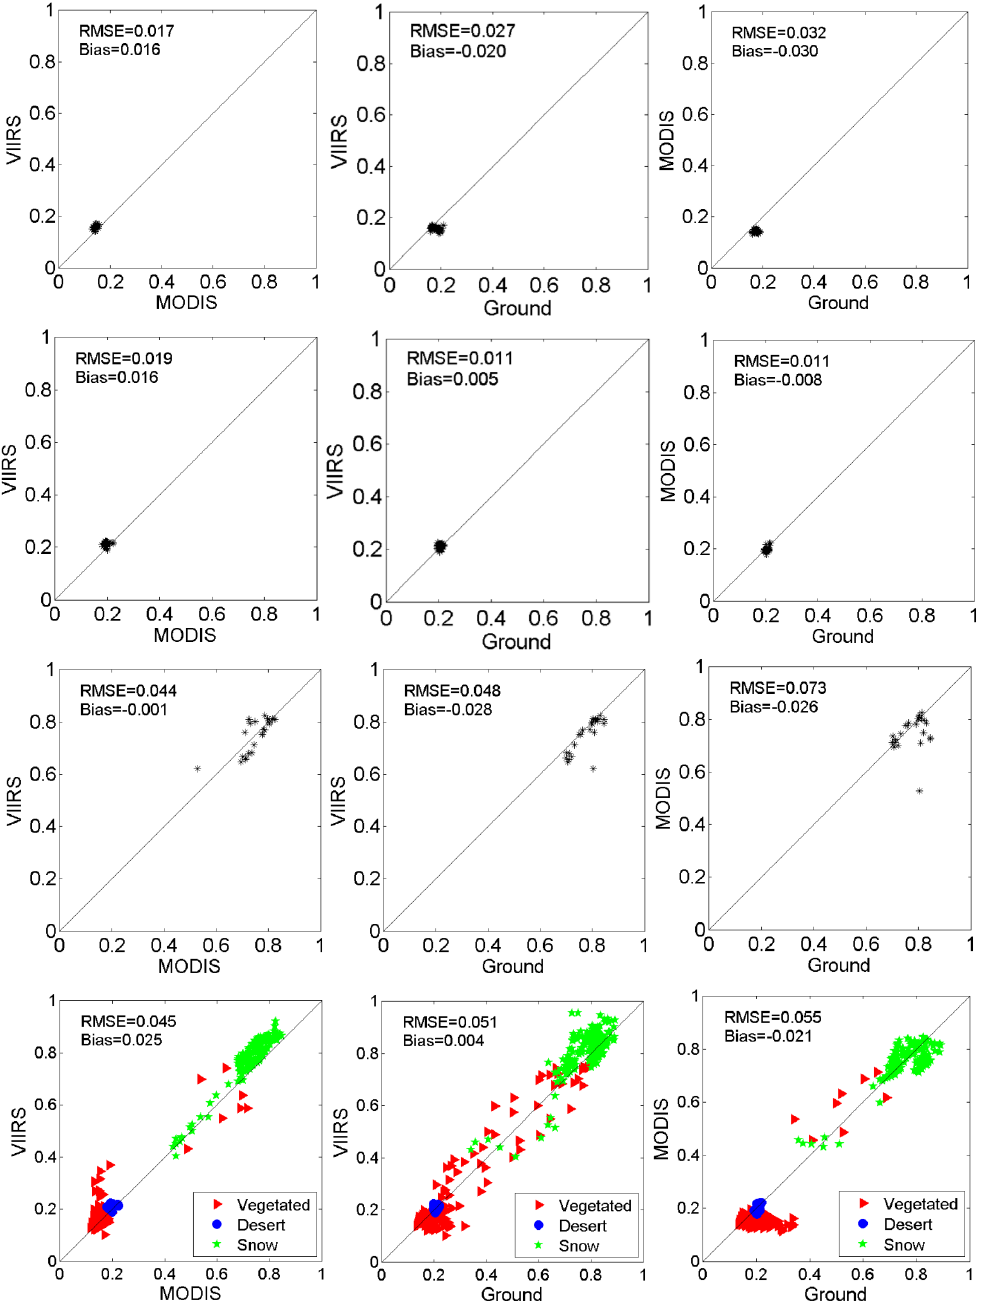
Figure 9. Intercomparison results (first column) between VIIRS LSA EDR and MODIS albedo product for the year 2013. Three individual sites (Goodwin Creek: first row; Desert Rock: second row; Saddle: third row) covered by different land types are shown, as well as the results of combining all the sites listed in Table 1 (fourth row). In addition, comparisons with field measurements are also provided for both the products in the second and third columns, respectively.